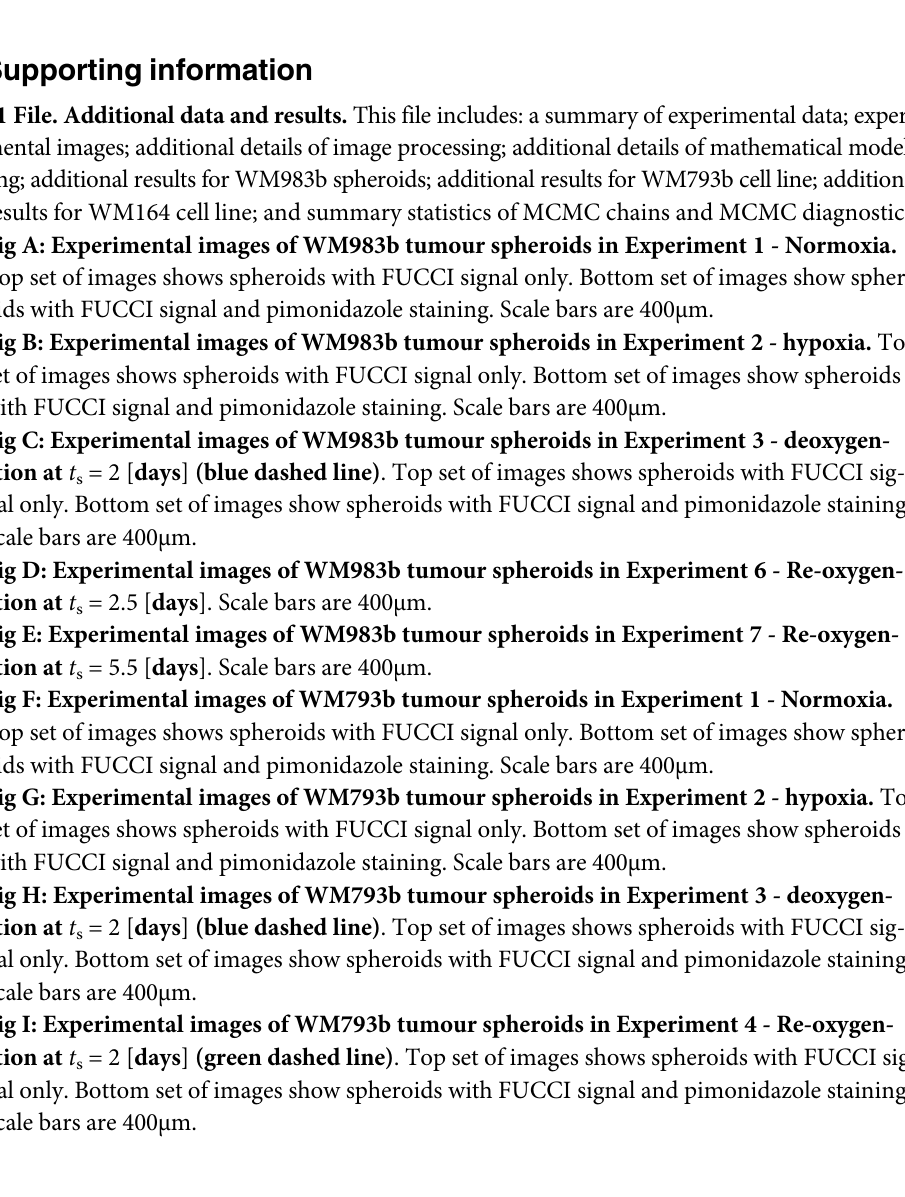
Top set of images shows spheroids with FUCCI signal only. Bottom set of images show spher- oids with FUCCI signal and pimonidazole staining. Scale bars are 400 μ m. Fig B: Experimental images of WM983b tumour spheroids in Experiment 2 - hypoxia. Top set of images shows spheroids with FUCCI signal only. Bottom set of images show spheroids with FUCCI signal and pimonidazole staining. Scale bars are 400 μ m. Fig C: Experimental images of WM983b tumour spheroids in Experiment 3 - deoxygen- ation at t = 2 [ days ] (blue dashed line) . Top set of images shows spheroids with FUCCI sig- s nal only. Bottom set of images show spheroids with FUCCI signal and pimonidazole staining. Scale bars are 400 μ m. Fig D: Experimental images of WM983b tumour spheroids in Experiment 6 - Re-oxygen- ation at t = 2.5 [ days ]. Scale bars are 400 μ m. s Fig E: Experimental images of WM983b tumour spheroids in Experiment 7 - Re-oxygen- ation at t = 5.5 [ days ]. Scale bars are 400 μ m. s Fig F: Experimental images of WM793b tumour spheroids in Experiment 1 - Normoxia. Top set of images shows spheroids with FUCCI signal only. Bottom set of images show spher- oids with FUCCI signal and pimonidazole staining. Scale bars are 400 μ m. Fig G: Experimental images of WM793b tumour spheroids in Experiment 2 - hypoxia. Top set of images shows spheroids with FUCCI signal only. Bottom set of images show spheroids with FUCCI signal and pimonidazole staining. Scale bars are 400 μ m. Fig H: Experimental images of WM793b tumour spheroids in Experiment 3 - deoxygen- ation at t = 2 [ days ] (blue dashed line) . Top set of images shows spheroids with FUCCI sig- s nal only. Bottom set of images show spheroids with FUCCI signal and pimonidazole staining. Scale bars are 400 μ m. Fig I: Experimental images of WM793b tumour spheroids in Experiment 4 - Re-oxygen- ation at t = 2 [ days ] (green dashed line) . Top set of images shows spheroids with FUCCI sig- s nal only. Bottom set of images show spheroids with FUCCI signal and pimonidazole staining. Scale bars are 400 μ